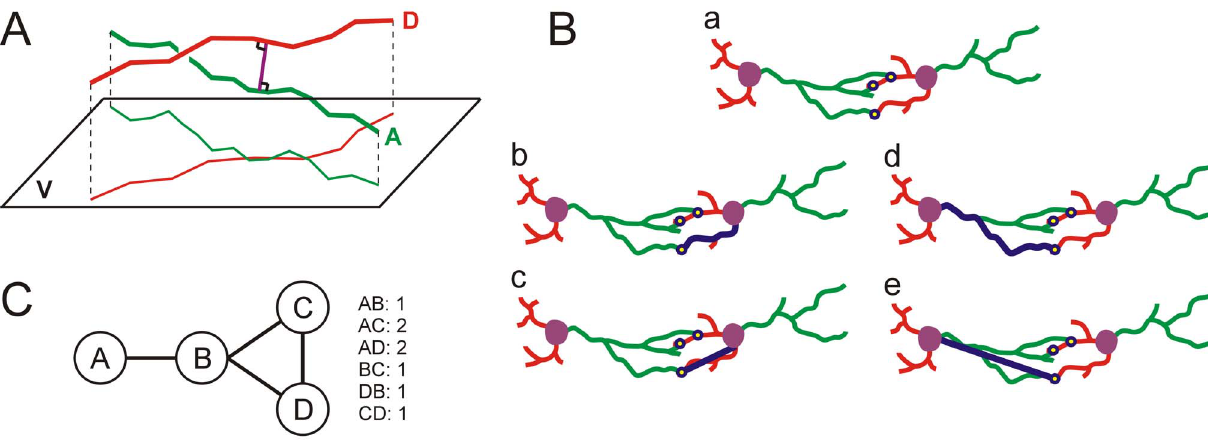
Figure 2. Synapse formation and illustration of measures characterizing synapse location and connectivity. A , Synapse formation in NETMORPH. The shortest distance between an axonal (A) and a dendritic (D) branch is defined as the orthogonal distance between a pair of crossing axonal and dendritic line pieces. If this shortest distance is smaller than a given threshold value, the orthogonal line (purple) marks the location of a synapse. B , Different ways to express synapse location. a , Two connected cells showing axons (green), dendrites (red), somata (purple) and synapses (yellow circles). b , Postsynaptic path distance (blue line). c , Postsynaptic Euclidean distance. d , Presynaptic path distance. e , Presynaptic Euclidean distance. C , Determining the mean shortest path length and clustering coefficient of an undirected graph consisting of four nodes and four edges. The numbers are the path lengths between the nodes. The mean shortest path length of the graph is the average of these numbers, 1.3333. The clustering coefficients of nodes A, B, C and D are 0, 2/6, 2/2, and 2/2, respectively. The clustering coefficient of the graph is the average of these numbers, 0.5833.